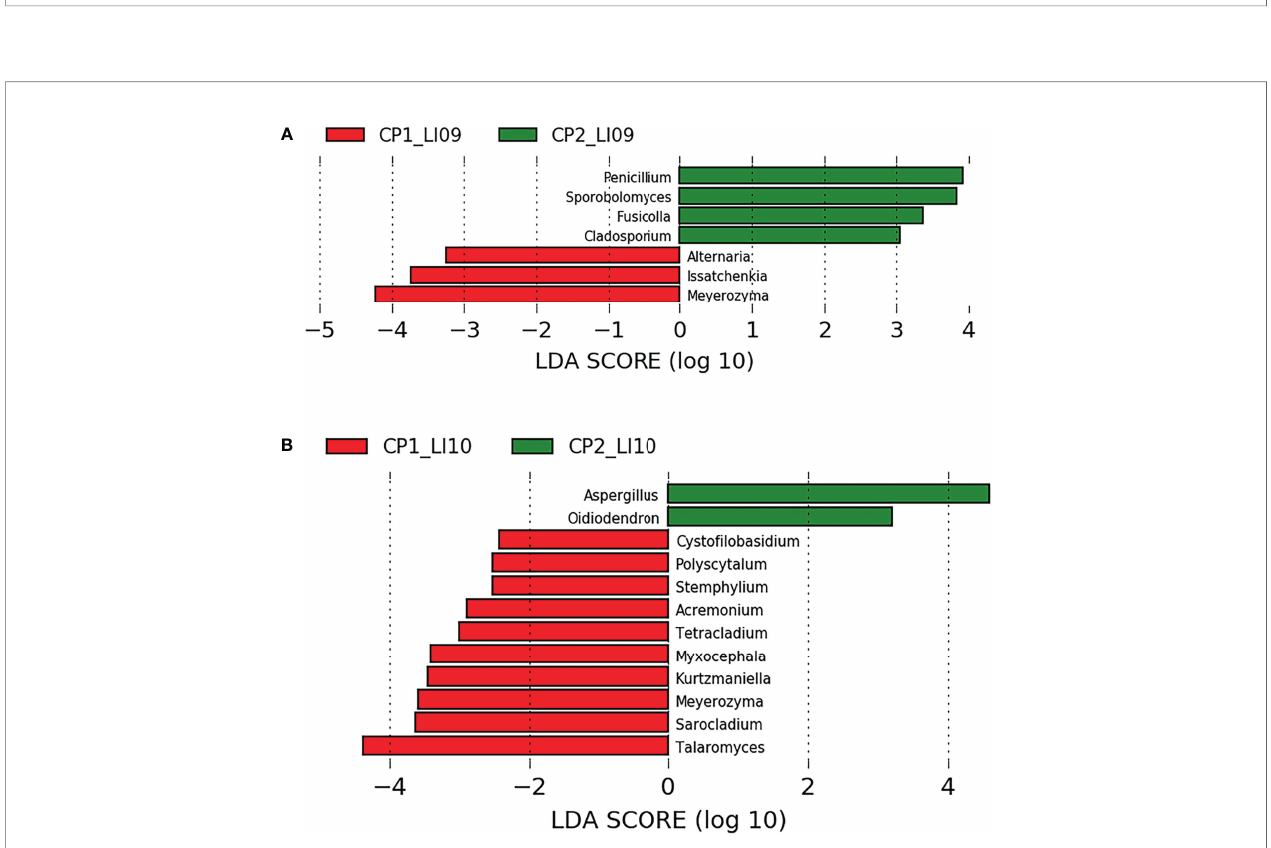
FIGURE 7 | Fungal family compositions in the LI09 and LI10 cohorts with different cytokine pro fi les, i.e., (A) CP1_LI09, (B) CP2_LI09, (C) CP1_LI10 and (D) CP2_LI10 cohorts.